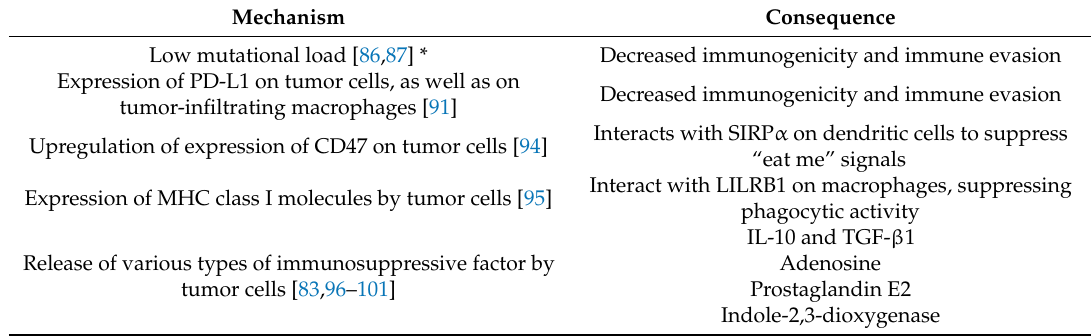
Table 1. Tumor-associated mechanisms which may restrict the efficacy of immunogenic cell death. Mechanism Consequence Low mutational load [86,87] * Decreased immunogenicity and immune evasion Expression of PD-L1 on tumor cells, as well as on Decreased immunogenicity and immune evasion tumor-infiltrating macrophages [91] Interacts with SIRP α on dendritic cells to suppress Upregulation of expression of CD47 on tumor cells [94] Expression of MHC class I molecules by tumor cells [95] Release of various types of immunosuppressive factor